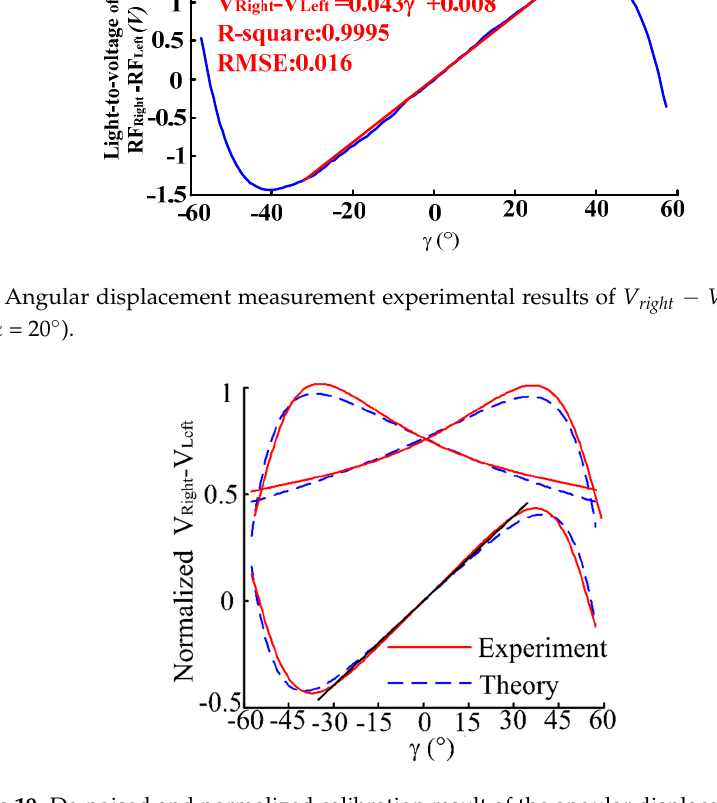
Figure 19. De-noised and normalized calibration result of the angular displacement sensor.